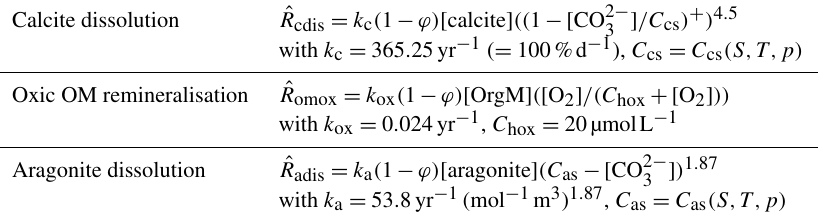
concentration in seawater at 3